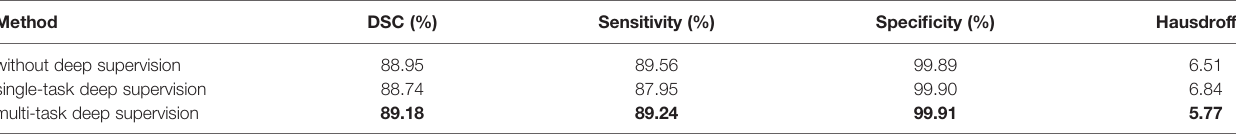
TABLE 4 | Ablation experiment of deep supervision on the BraTS